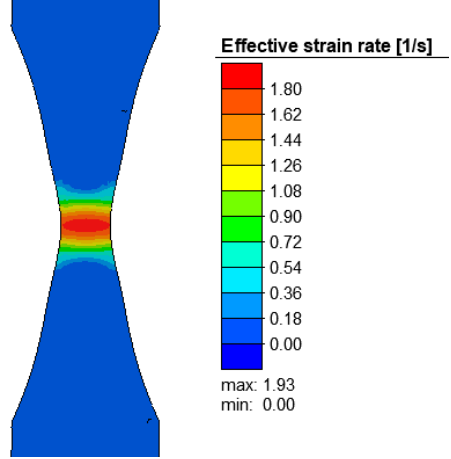
Figure 7. Effective strain rate (in s − 1 ) in the axial section of the R200 steel sample under the tensile test at 1100 °C.